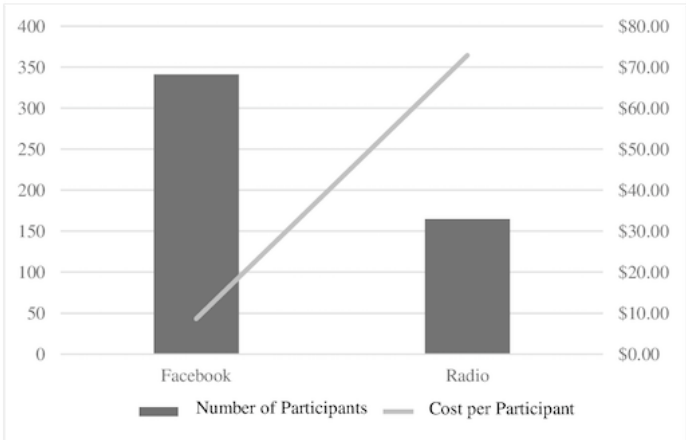
Figure 1. Comparison of the cost-efficiency of the Facebook and radio advertising